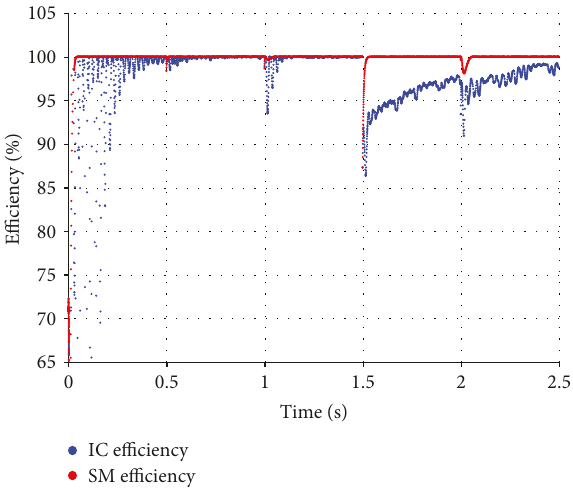
Figure 10: Tracking e ffi ciencies of the SM-MPPT and the incremental conductance